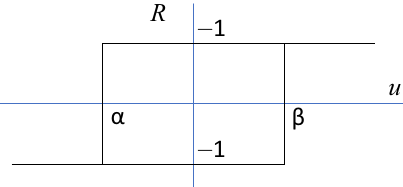
Figure 3. The input–output relation of the converter R